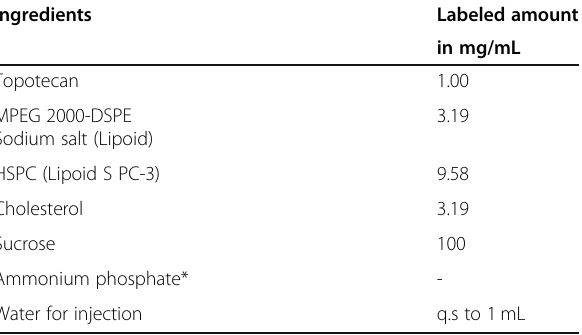
Table 2 Composition of topotecan liposome formulation